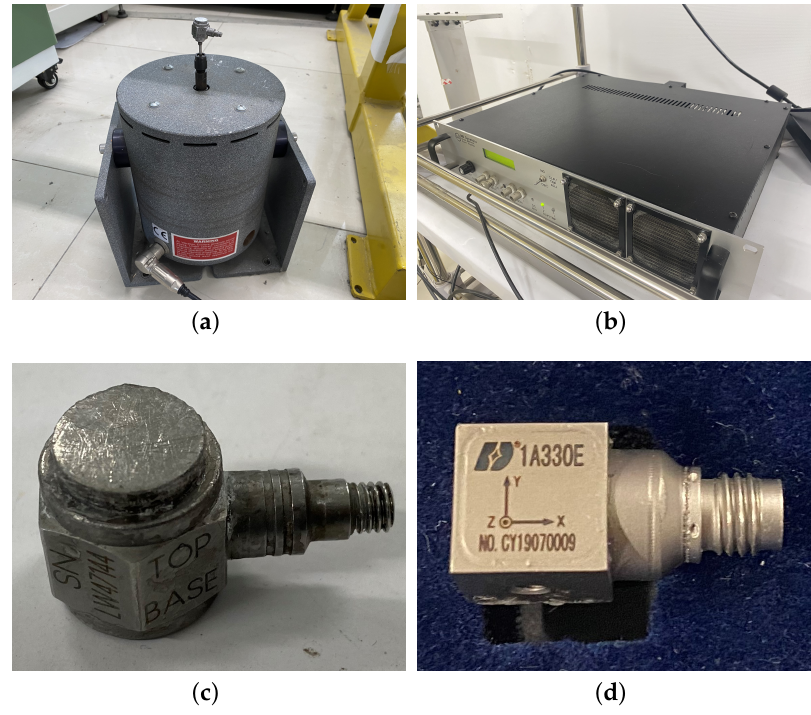
Figure 4. Equipment used in the data collection system. The dynamic loads are from the vibration exciter and amplified using the power amplifier. The dynamic loads are measured by the force sensor. Responses from each measurement points are measured by the accelerometers. ( a ) The vibration exciter. ( b ) The power amplifier. ( c ) The force sensor. ( d ) The accelerometer. Throughout the experiment, the random signals of both exciters are white